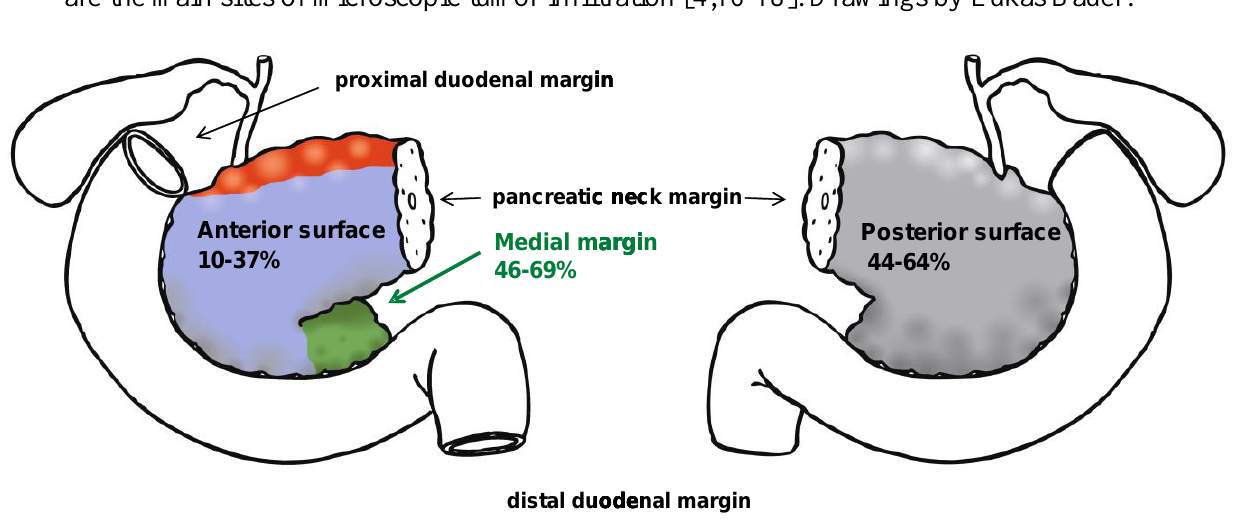
Figure 1. Pancreatoduodenectomy specimens: The posterior surface and the medial margin are the main sites of microscopic tumor infiltration [4,16-18]. Drawings by Lukas Bauer.